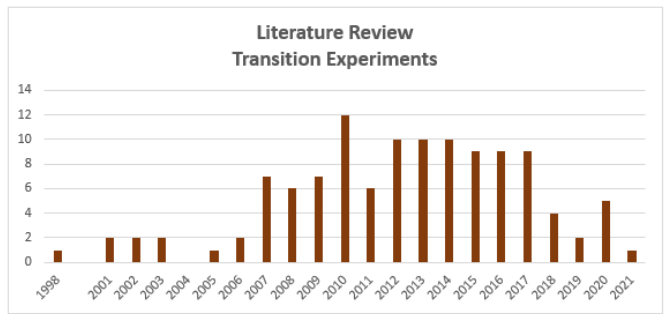
Figure 1. Year of publication of the 118 documents selected in the literature review of TE.